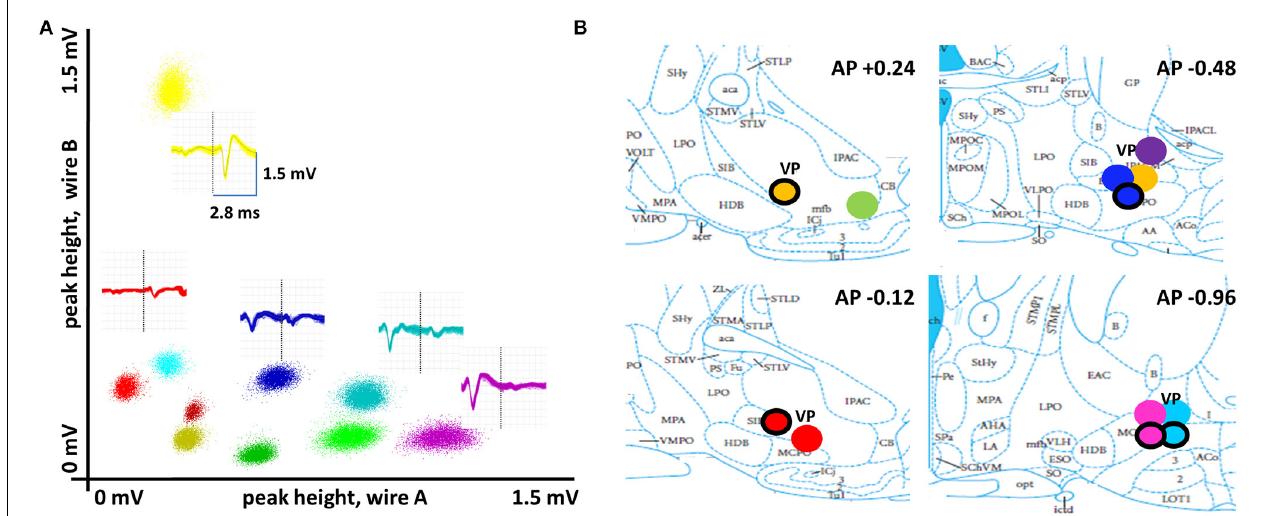
FIGURE 2 | Basal forebrain recording sites and properties of spike waveforms. (A) Spike waveforms for multiple single neurons recorded with stereotrodes were discriminated according to their clustering along multiple dimensions of waveform parameters. Here, peak heights on each wire of a stereotrode are plotted against each other for all spikes of 10 basal forebrain neurons. An overlay of the full set of waveforms is given for five of these